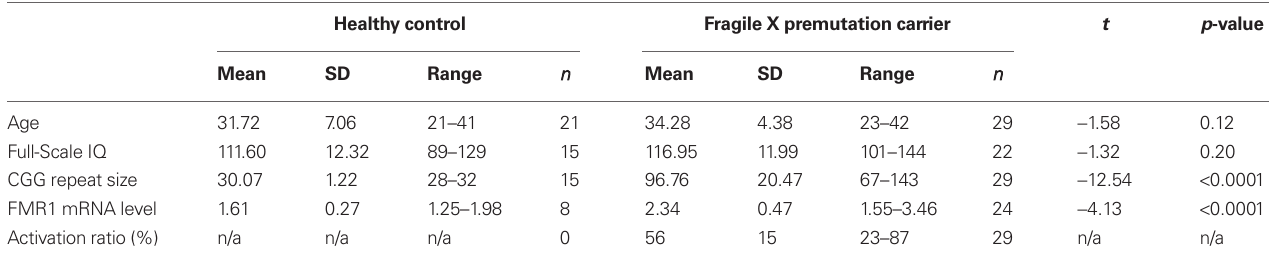
Table 1 | Participant descriptive statistics and FMR1